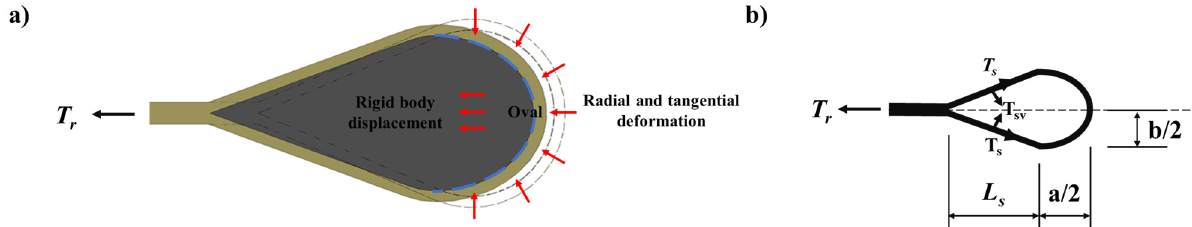
Figure 5. ( a ) Deformation and displacement of the U-head and the pin under tension; ( b ) deformation-considered mechanical model of the U-head.